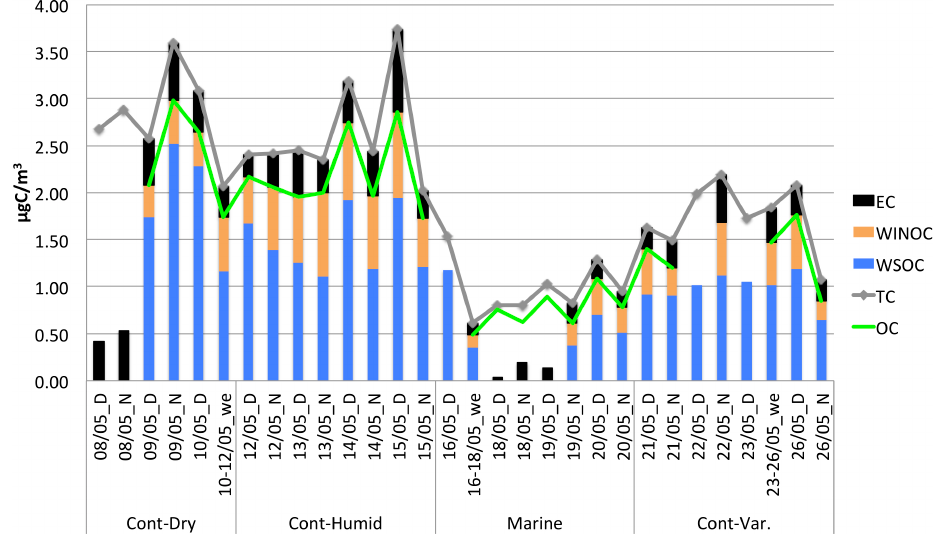
Fig. 2. Concentrations of total/organic/elemental (TC/OC/EC) carbon and of water-soluble organic carbon (WSOC) from evolved gas analysis (EGA) and thermo-oxidative